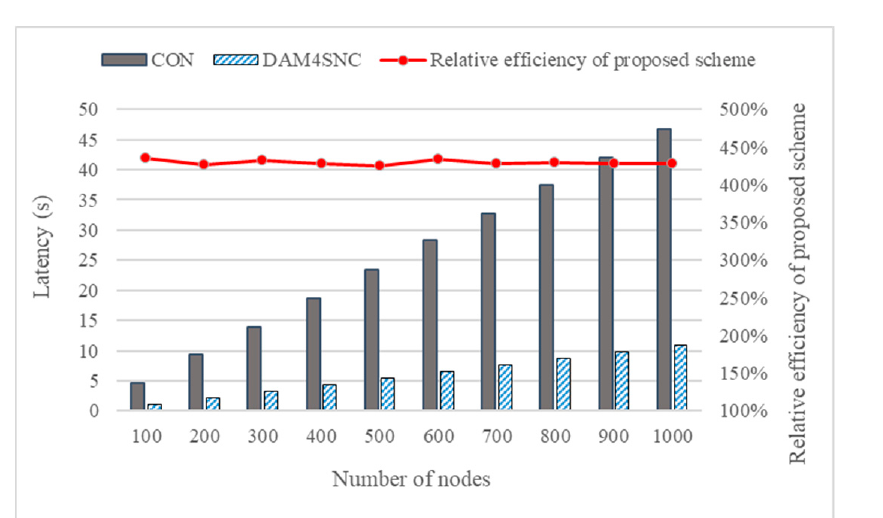
Figure 5. Comparison between the DAM4SNC and CON models.